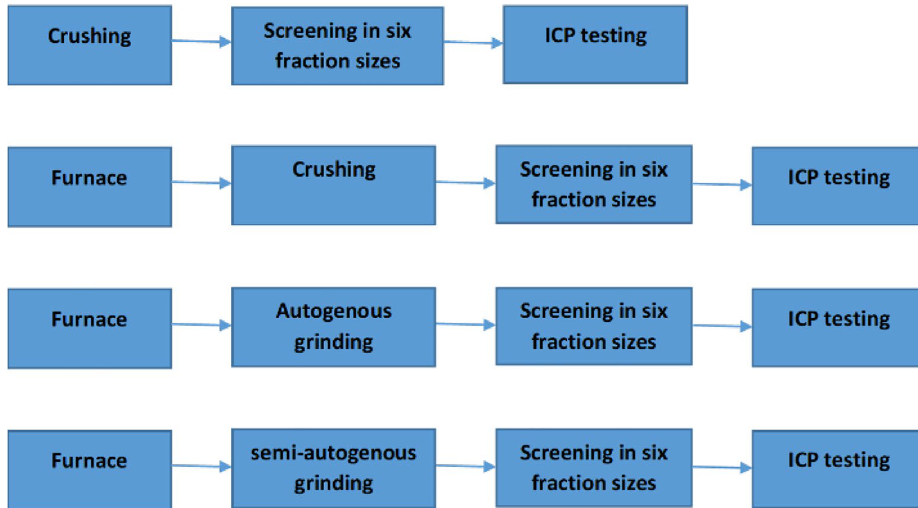
Figure 1. The experimental flowcharts.